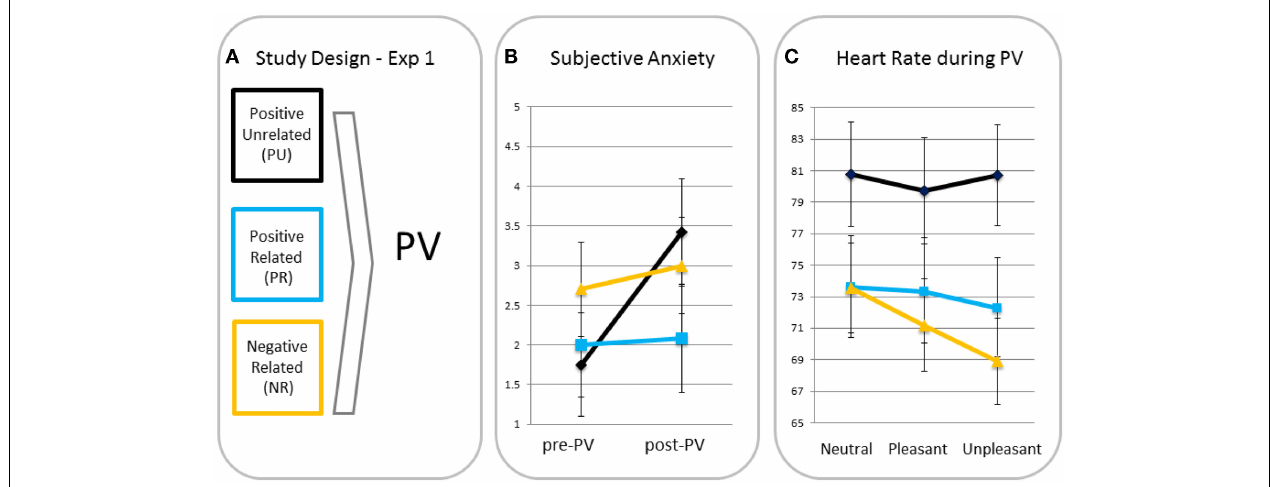
FIGURE 1 | Study design (A), subjective anxiety pre- and post-passive viewing [PV; (B)] and heart rate in response to neutral, pleasant, and unpleasant pictures (C) for participants in the positive unrelated (PU), positive related (PR), and negative related (NR) script condition